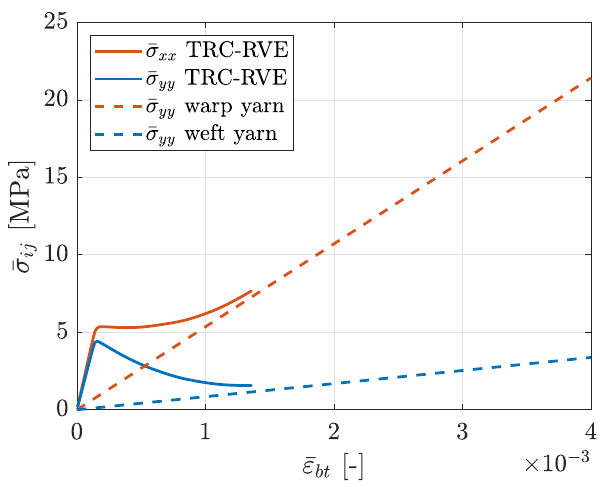
Figure 17. Effective macroscopic stress–strain relation due to biaxial tensile loading with prescribed strain ¯ (cid:101) = [ ¯ (cid:101) xx = ¯ (cid:101) bt , ¯ (cid:101) yy = ¯ (cid:101) bt , ¯ γ xy = 0 ]